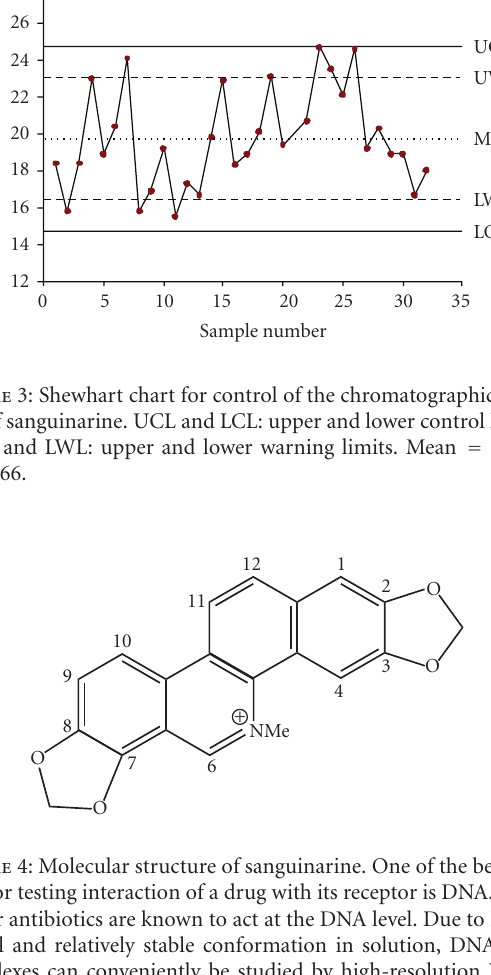
Table 3: Sanguinarine levels (mgL − 1 ) in tissue culture